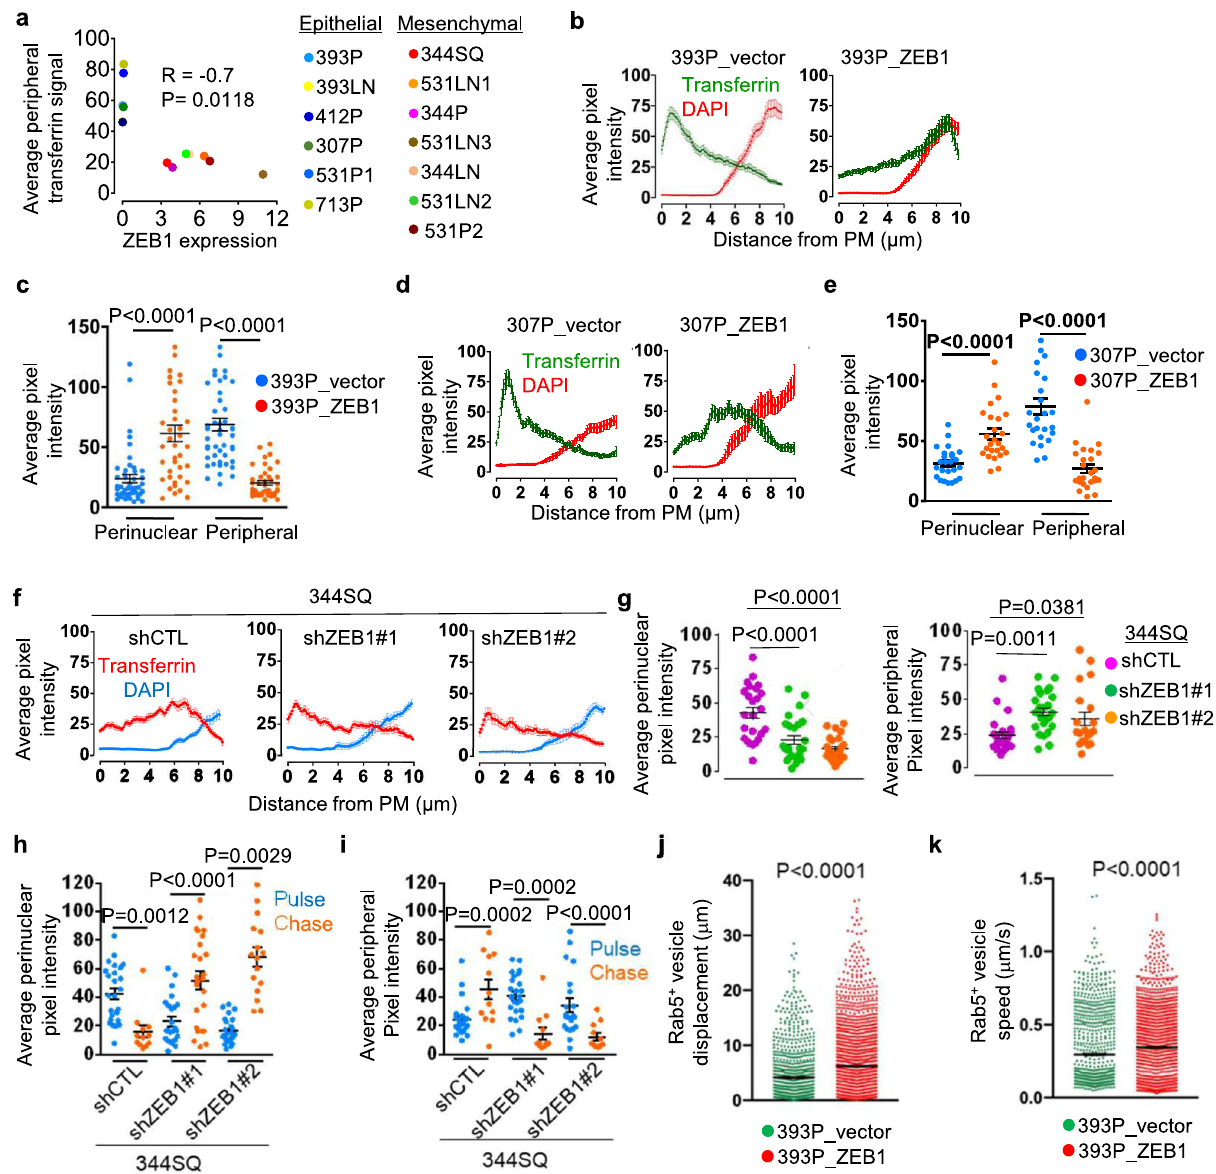
Fig. 3 ZEB1 accelerates vesicular traf fi cking through the endocytic recycling pathway. a Correlation of endogenous ZEB1 expression levels with Alexa 568-labeled Tfn signal intensities in peripheral compartments of murine LUAD cell lines fi xed 10 min after initiating endocytosis. b Alexa 568-labeled Tfn and DAPI signal intensities ( y -axis) on straight lines drawn from the PM inwards ( x -axis) in 393P cells that have an ectopic expression of ZEB1 or empty vector. Cells fi xed 10 min after initiating endocytosis. Results represent averages of 3 linescans per cell, ≥ 40 cells per cell line. c Tfn signal intensities in perinuclear and peripheral compartments of each cell (dot). Values represent the maximal signal intensities in each cell. n = 47 cells (393P_vector) or 40 cells (393P_ZEB1) cells from 3 independent experiments. d , e Alexa 568-labeled Tfn linescan plots ( d ) and perinuclear and peripheral signal intensities ( e ) in 307P cells that have an ectopic expression of ZEB1 or empty vector and were fi xed 10 min after initiating endocytosis. n = 25 cells from 3 independent experiments. f , g Alexa 568-labeled Tfn linescan plots ( f ) and perinuclear and peripheral signal intensities ( g ) in ZEB1 (shZEB1 #1 or #2)- or control (shCTL) shRNA-transfected 344SQ cells fi xed 10 min after initiating endocytosis. n = 25 cells (shZEB1 #1) or 20 cells (shZEB1 #2) from 3 independent experiments. h , i Tfn signal intensity in shZEB1- and shCTL-transfected 344SQ cells pulsed for 10 min with Alexa 568-labeled Tfn and chased for 10 min with unlabeled Tfn. Signal intensities in perinuclear ( h ) and peripheral ( i ) compartments after pulse alone (blue) or pulse/chase (red) were determined. Values represent the maximal signal intensities in each cell. For pulse/chase ( h ), n = 12 cells (shCTL), 25 cells (shZEB1 #1), or 16 cells (shZEB1 #2) from 2 independent experiments. For pulse/chase ( i ), n = 12 cells from 2 independent experiments. j , k Displacement ( j ) and speed ( k ) of each Rab5 + vesicle (dot) in 39P_vector cells and 393P_ZEB1 cells that express mCherry-tagged Rab5, an early endosomal marker. Data represent mean ± S.E.M ( n = 3 movies, 2 cells per movie, 600 frames per cell). Data are presented as mean values ± SEM; R value, Spearman; P values, two-tailed Student ’ s t test; or ANOVA ( g between endosomes and the trans -Golgi network 34 – 36 . In line